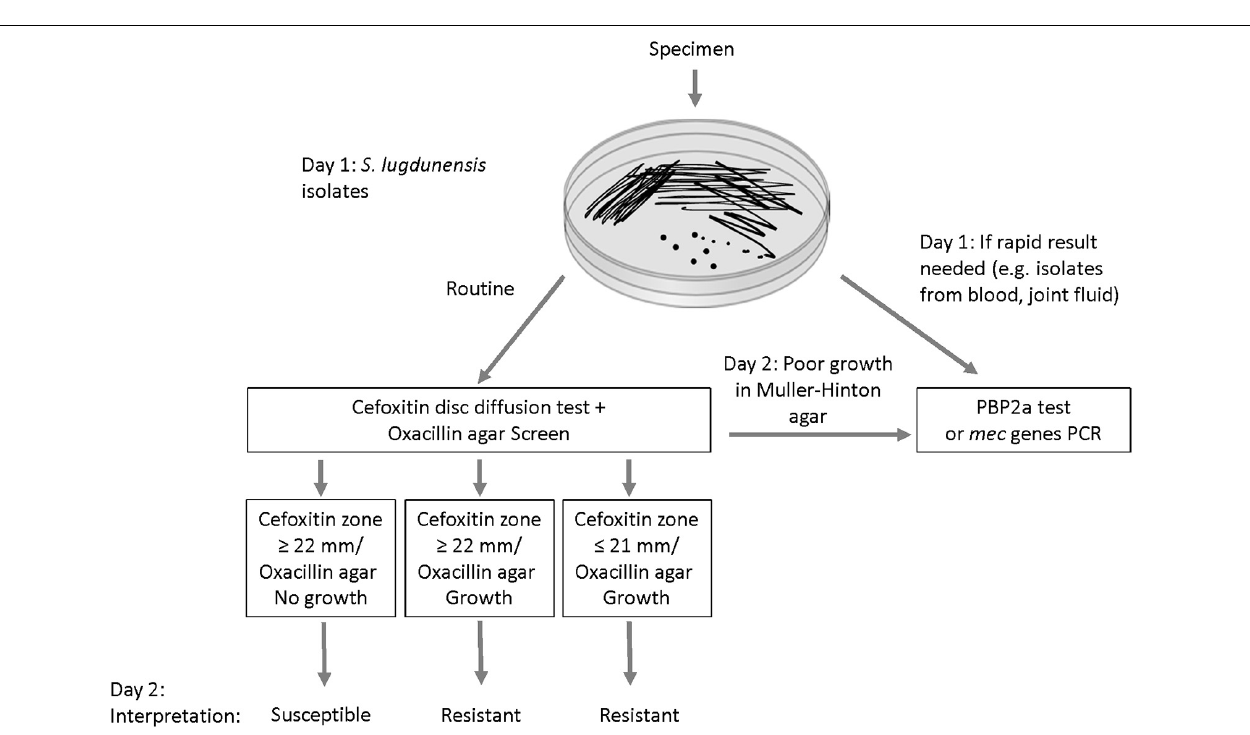
FIGURE 4 | Proposed algorithm for improving the detection of mecA -mediated oxacillin resistance in Staphylococcus lugdunensis.